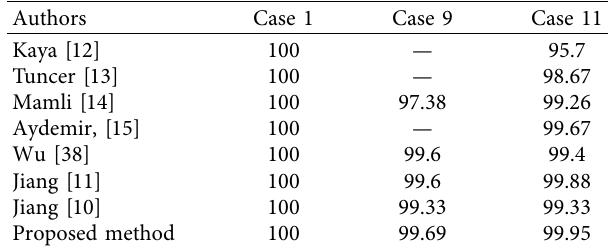
Table 7: Comparison of the proposed method with the state-of- the-art methods for cases 1, 9, and 11 using University of Bonn database in terms of classifcation accuracy (%).